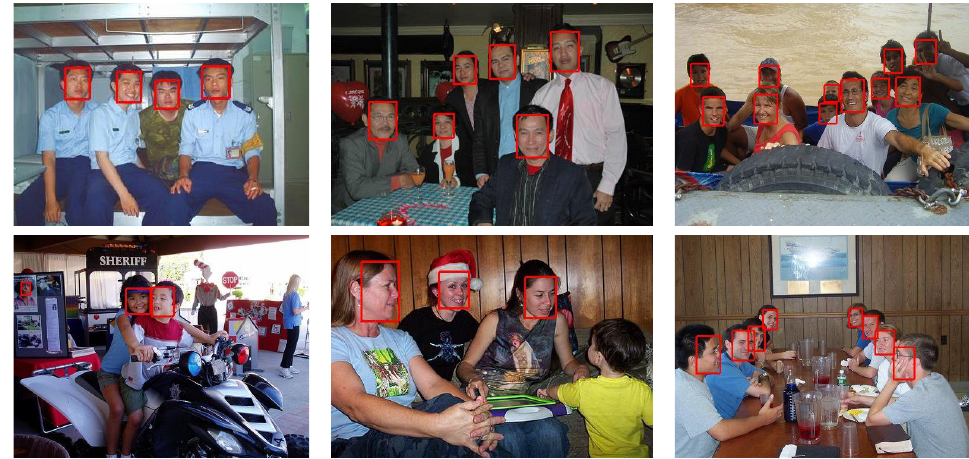
Figure 13. Visualization of the results of EagleEye on Pascal face